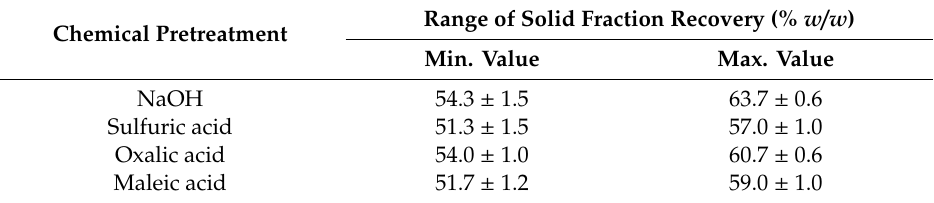
Table 1. Percent of solid fraction recovery of sugarcane bagasse (SCB) after